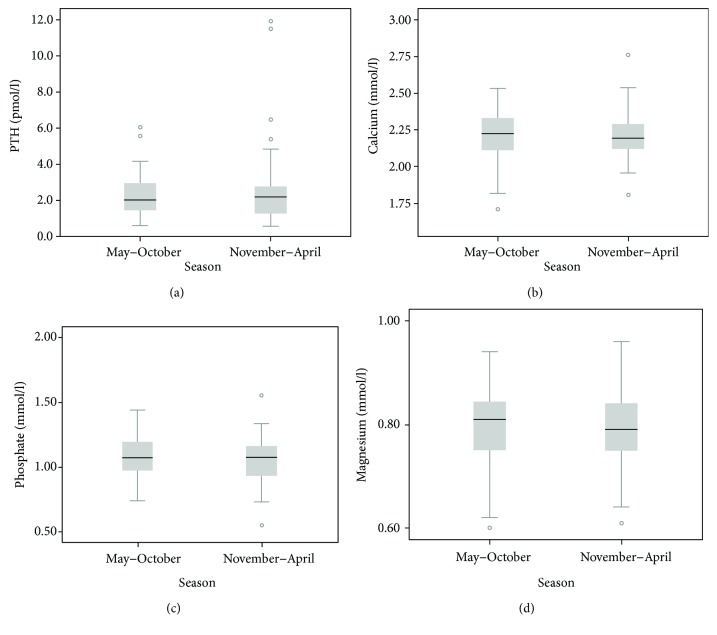
Seasonal variation in calcium metabolic parameters.